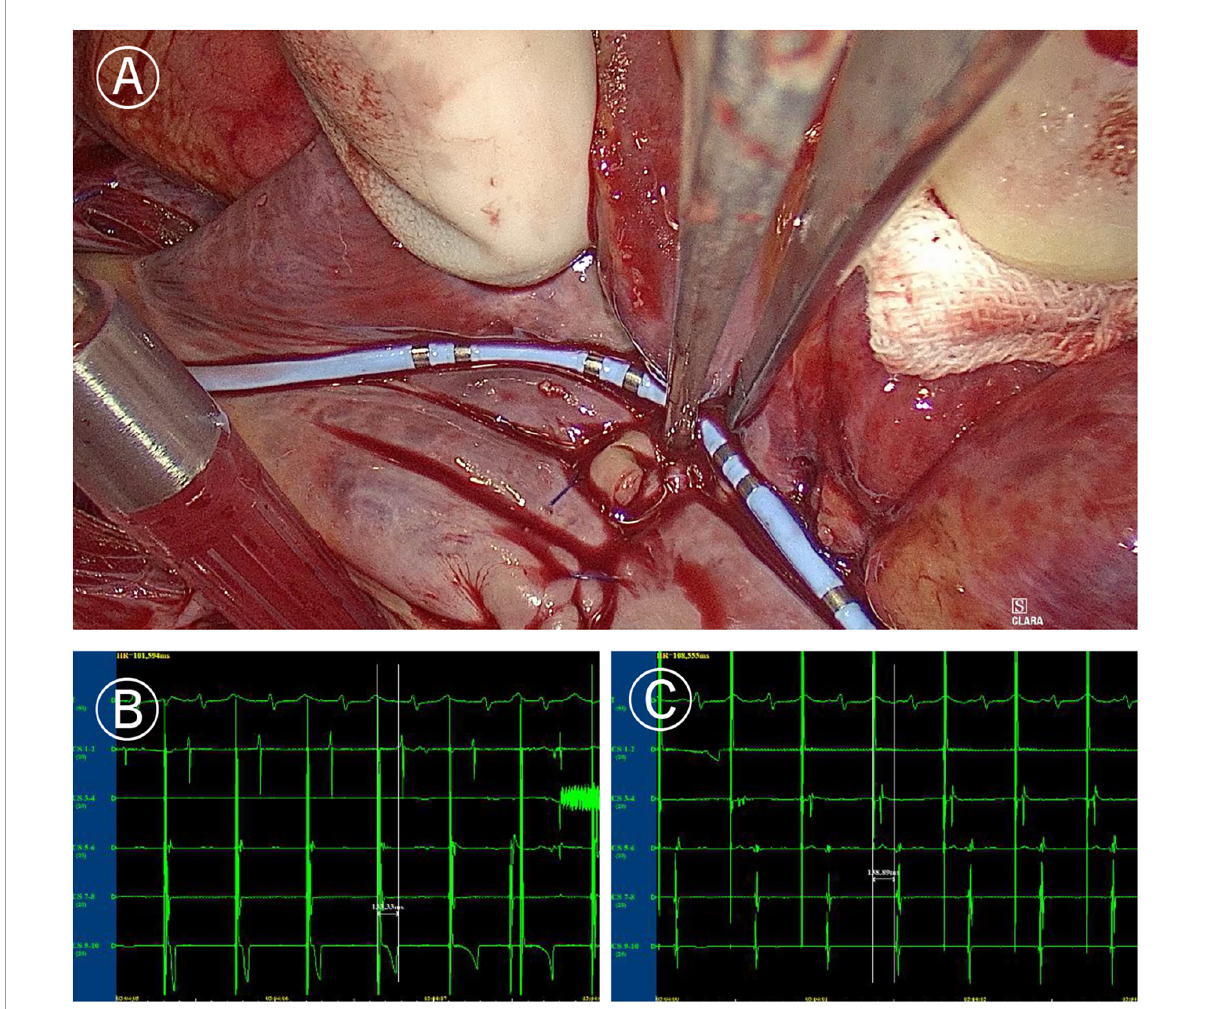
FIGURE4 Mapping of tricuspid valve annular ablation line. (A) Coronary sinus catheter mapping of tricuspid valve annular ablation line. (B) Distal polar in free side wall of the right atrium (CS1-2) delay during proximal polar near the anterior atrial sulcus (CS9-10) pacing of coronary sinus catheter (more than 120 ms). (C) Proximal delay during distal pacing of coronary sinus catheter (more than 120